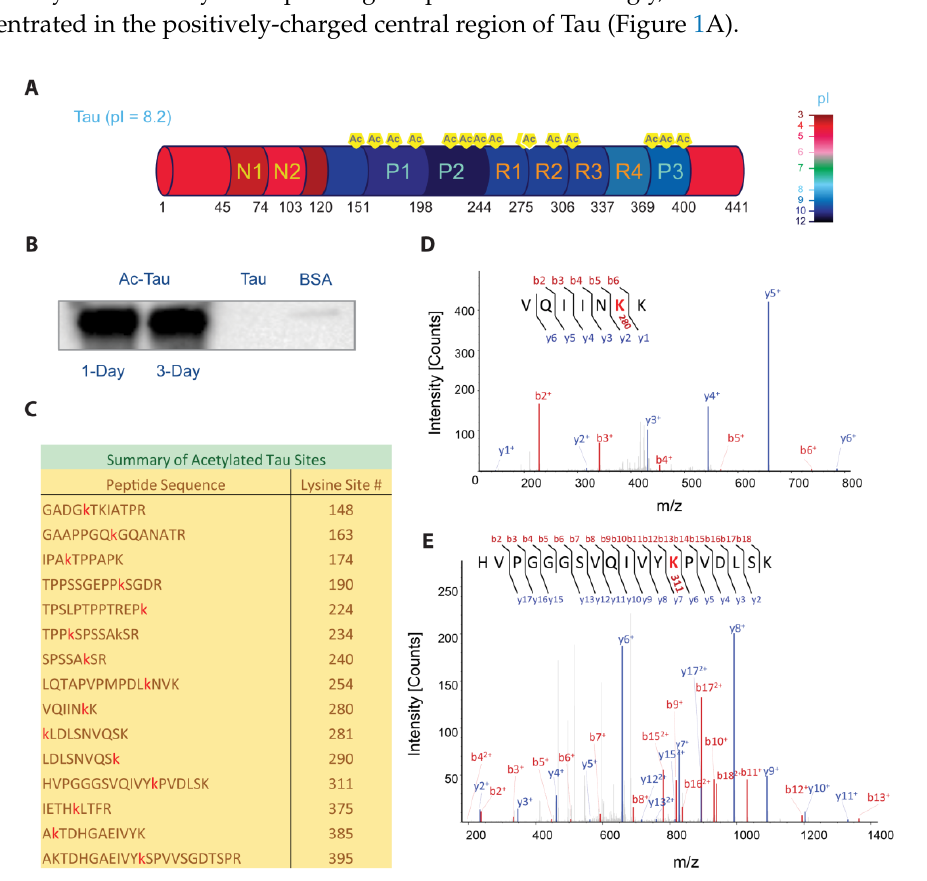
Figure 1. Tau hyperacetylation. ( A ) Domain organization of Tau. Protein segments are color-coded to reflect their respective pIs using the provided color palette. ( B ) In vitro Tau acetylation was verified by Western blot against acetyl-lysine (left to right lanes: acetylated Tau after one- and three-day reaction incubations, and negative controls using wild-type Tau and BSA, respectively). ( C ) Tau lysine acetylation sites (red) identified by mass spectrometry. ( D , E ) MS/MS spectra of peptides that contain the hexapeptide aggregation motifs VQIINK 280 K 281 and VQIVYK 311 , showing acetylation at K280 and K311, respectively (shown in red). The ‘b’ ions (shown in red) represent fragment peaks generated from the amino to carboxyl terminus. The ‘y’ ions (shown in blue) represent fragment peaks generated from the carboxyl to amino terminus. The suffix numbers represent the corresponding number of amino acids. See Section 3 for details.